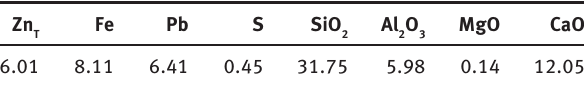
Table 1: The chemical composition of low grade zinc oxide ore (mass fraction, %)